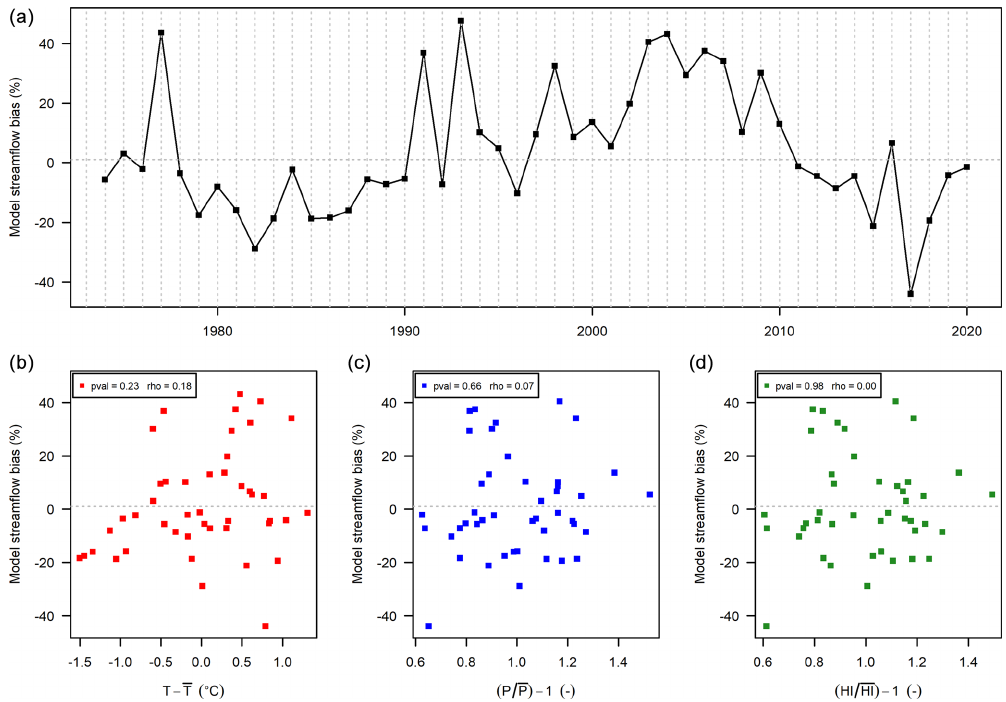
Figure 6. Streamflow annual bias obtained with the RAT function of time (a) , temperature absolute anomalies (b) , and precipitation P (c) and humidity index P/E 0 (d) anomalies, for the Orne Saosnoise River at Montbizot (M0243010) (510km 2 ).